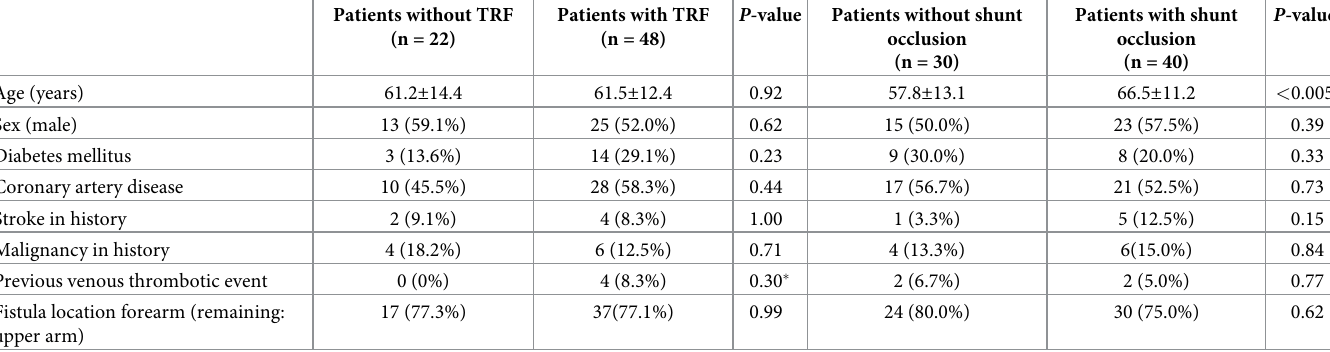
Table 1. Characterization of patients with and those without thrombophilic risk factors (TRFs) and patients with and without shunt